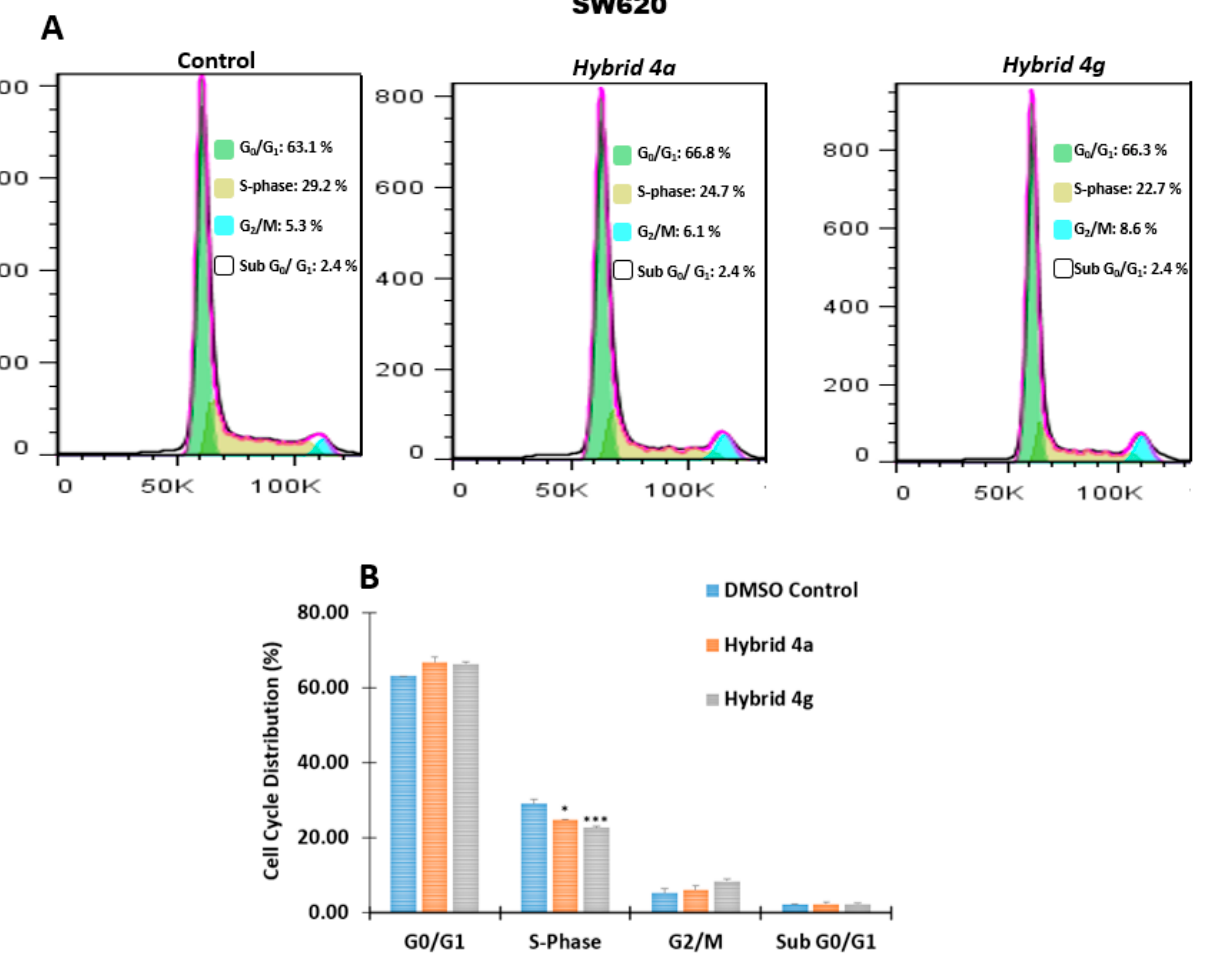
Figure 5. Percentage of cell cycle distribution in SW620 cells ( A ) after the treatment with hybrids 4a and 4g . DMSO (1%) was used as vehicle control. Representation of data in bar chart form ( B ). DNA was stained with PI. Analysis was made by flow cytometry. One representative image is shown from two independent experiments. p values lower than 0.05 were considered statistically significant (* p < 0.05; *** p < 0.001).